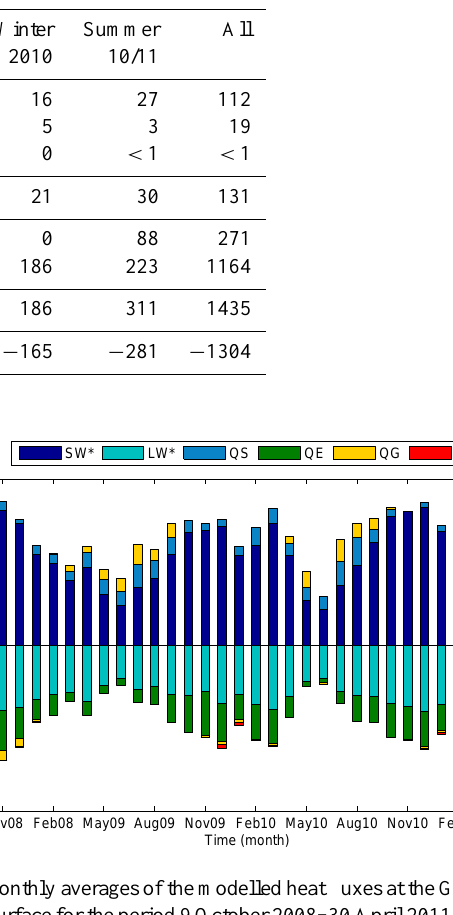
cally the latent heat flux, have been shown to play an impor- tant role in the surface energy balance on Guanaco Glacier (Fig. 4) it is vital that we test the sensitivity to model param- eters. The model was run using a stability correction based on the Richardson number (standard run), and without the stability correction (stability – off; Table 4). From this anal- ysis it appears that the use of a stability function does not significantly alter the modelled result (RMSE 6.8 mm). Ad- ditionally, the difference in calculated melt between the run with and without using the stability function is small ( − 3 % change), as is the impact on sublimation and net ablation (8 % and 6 % changes, respectively). This small impact is not surprising as it has been shown that meteorological con- ditions in similar environments only cause slight fluctuations around near-neutral stability (e.g. Fig. 6 in Mölg and Hardy,